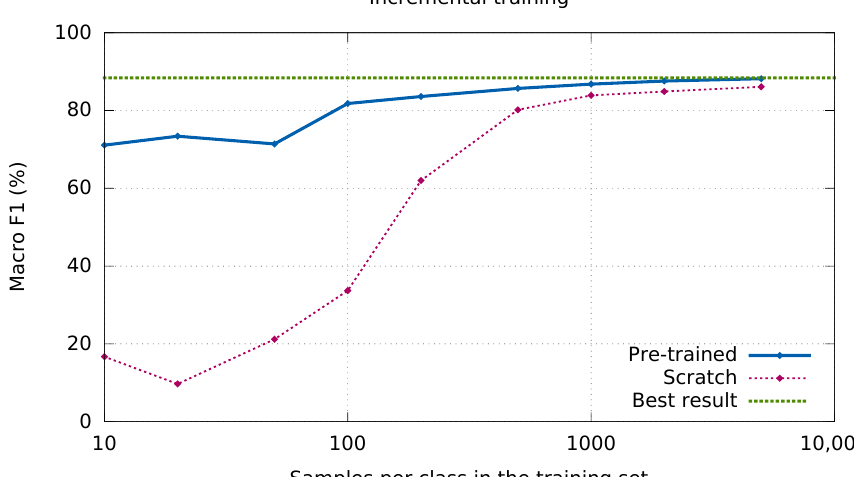
Figure 11. Comparison of the evolution of the learning process (in terms of F M the size of the training set. The plain blue curve shows the evolution starting from a pre-trained network, while the broken red one represents the results when the network is trained from scratch. The green broken line indicates the best result obtained for this manuscript. Note that the x -axis presents a logarithmic